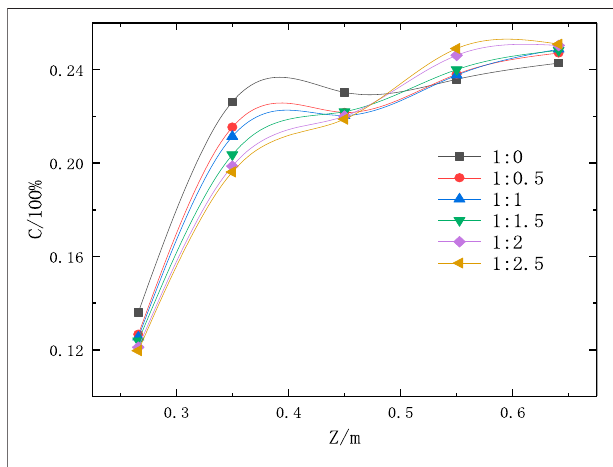
FIGURE 10 | Average Fe 2 O 3 concentrations on monitored surfaces in the reactor at different citric acid ratios.